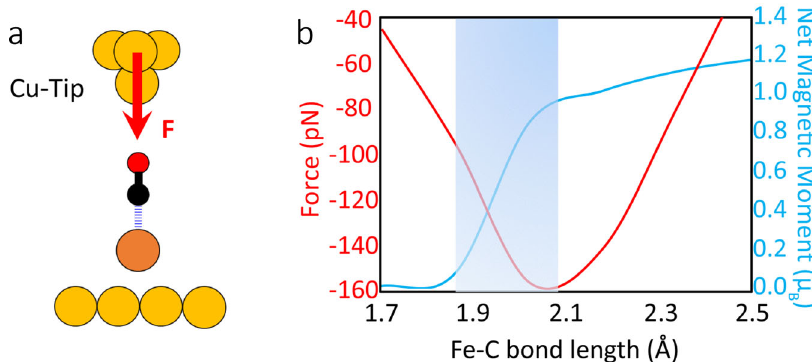
Fig. 3 Real-space pseudopotential DFT calculations for the breaking of the dative bond in CO-FePc with a Cu tip. a Schematic showing the interaction of the Cu tip with the CO-FePc complex on Cu(111) (Cu: yellow; C: black; O: red; Fe: brown). The red arrow indicates the attractive force acting on the tip apex. b The red curve shows the calculated attractive vertical force on the Cu apex while the blue curve shows the net magnetic moment as a function of the Fe-C bond length. The shaded area indicates where the bond rupture process occurred.